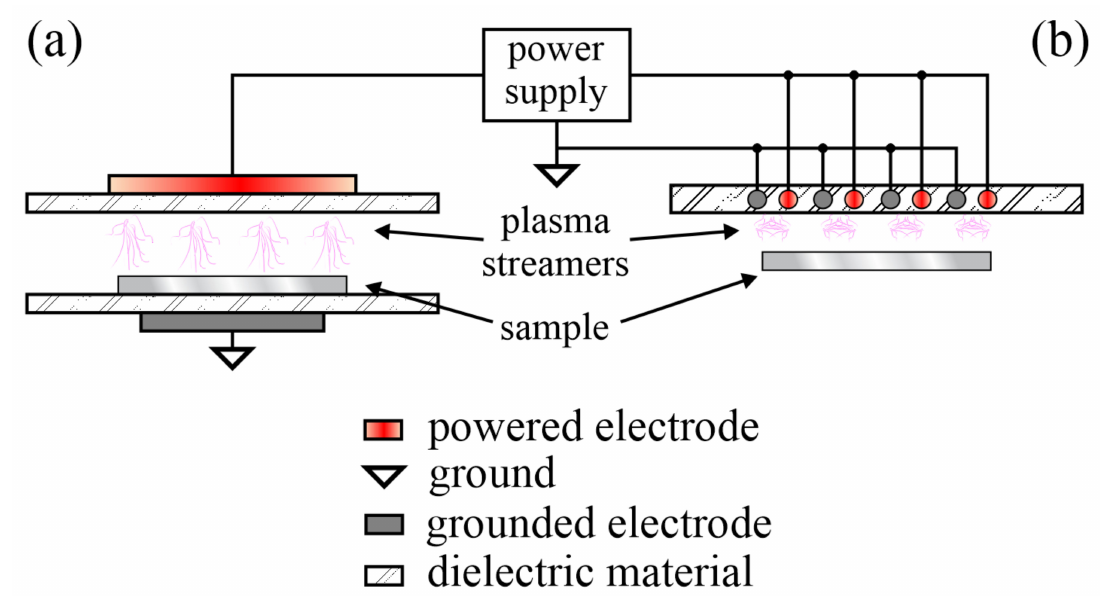
Figure 2. Schematic of atmospheric pressure dielectric barrier discharge in a classical ( a ) and coplanar ( b )